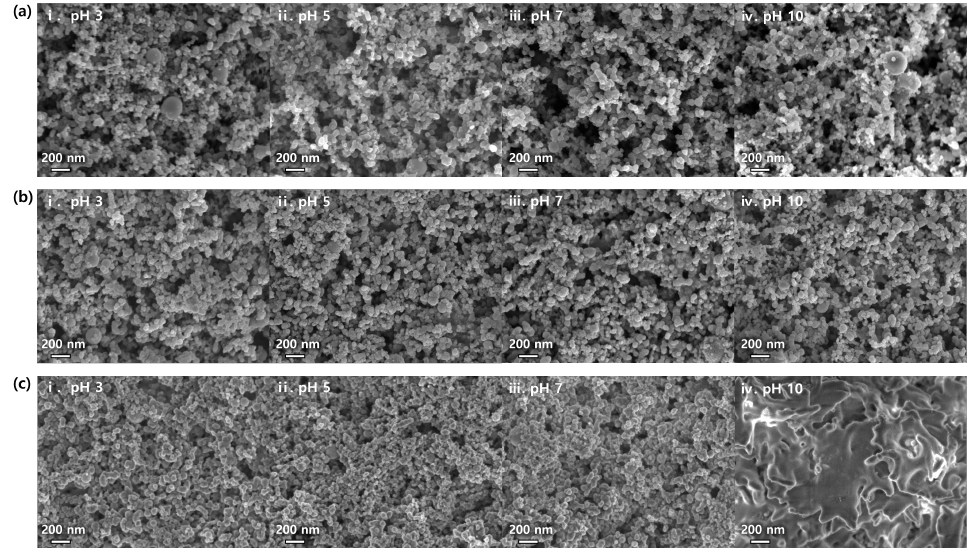
Figure 2. FE-SEM images of anode slurries with various binders at different pH conditions: ( a ) PAA; ( b ) CMC/SBR; ( c ) chitosan: (i) pH 3, (ii) pH 5, (iii) pH 7, and (iv) pH